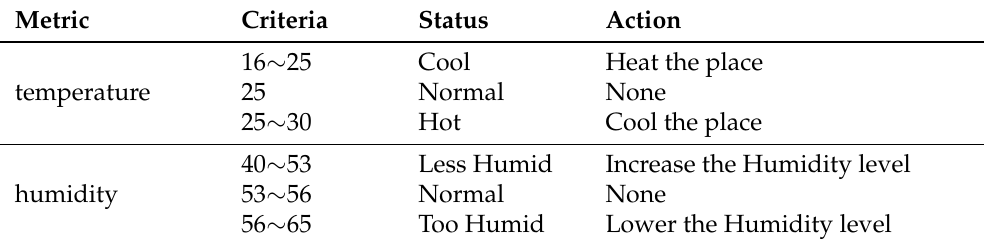
Table 9. Criteria for controlling the temperature and